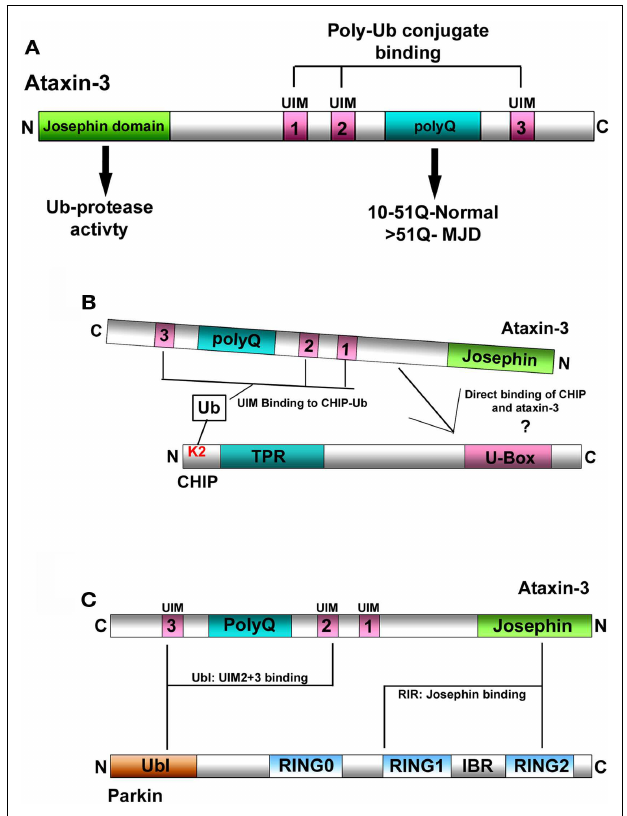
FIGURE 1 | (A) Schematic representation of ataxin-3. Ataxin-3 contains an N-terminal Josephin domain, and three Ub-interacting motifs (UIMs) that flank a polyQ tract of variable length. In normal individuals, this tract can be anywhere from 10 to 51Q. In individuals with MJD, this tract has expanded to now contain > 51Q. (B) Schematic representation of the interaction between ataxin-3 and CHIP. (1) CHIP contains an N-terminal tetratricopeptide repeat (TPR) domain and a C-terminal U -Box domain that confers CHIP with E3-Ub ligase activity. CHIP monoubiquitinates itself at lysine 2 (K2), which in turn facilitates the interaction between CHIP and ataxin-3. CHIP and ataxin-3 also interact directly although the nature of this interaction has yet to be characterized. (C) Schematic representation of the interaction between ataxin-3 and parkin. Parkin interacts directly with ataxin-3 via its N-terminal Ub-like domain (Ubl) that binds to the UIMs of ataxin-3, and through its inbetweenring-RING2 (IBR-RING2) domain binding to the Josephin domain of